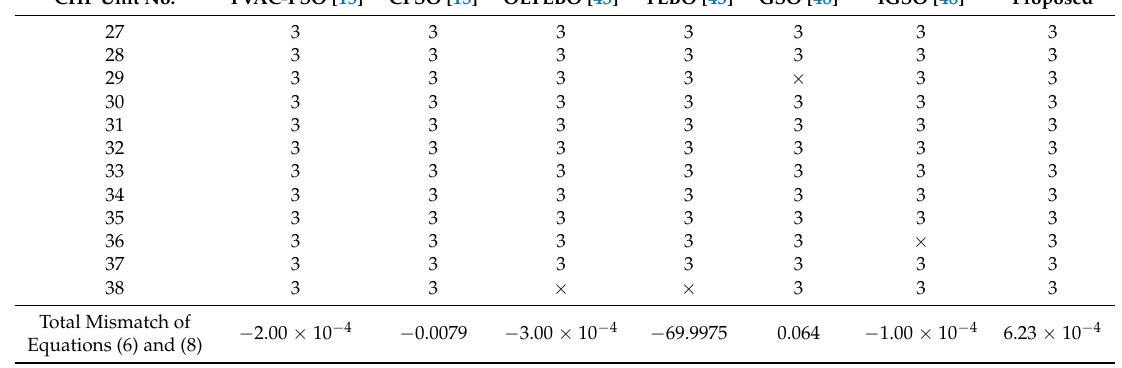
Table 13. Feasibility analysis of the obtained results for 48-unit test system. CHP Unit No.